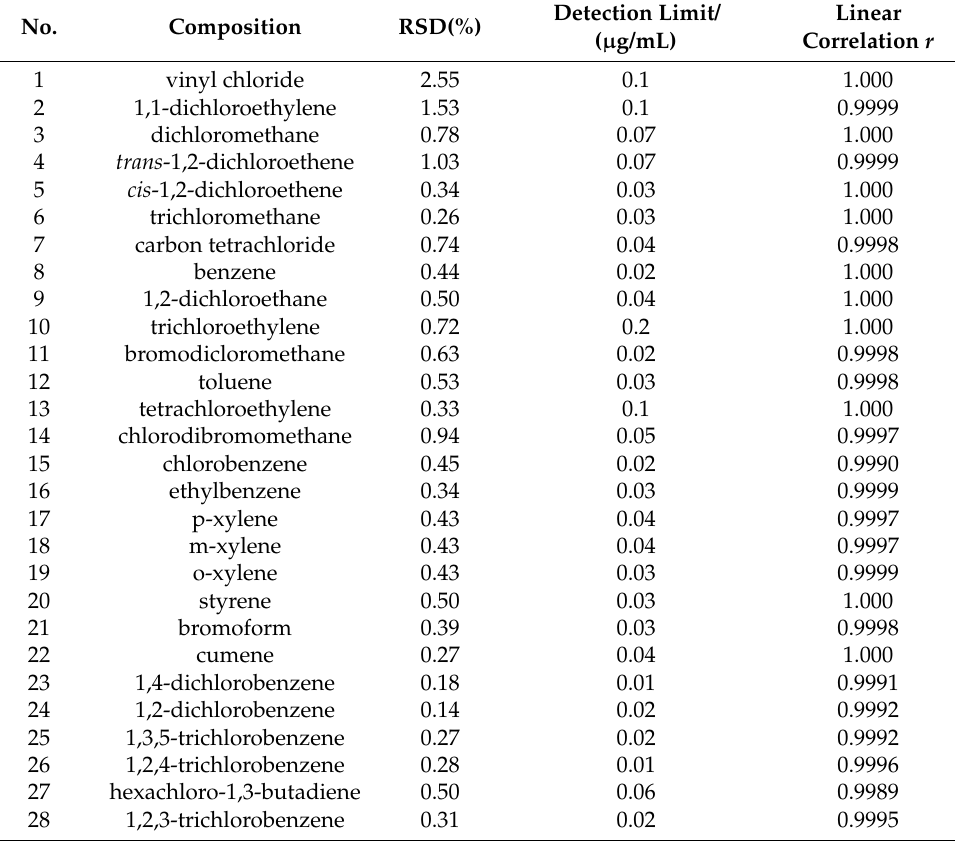
Table 1. Precision and detection limits of 28 VOCs in methanol using GC-MS.